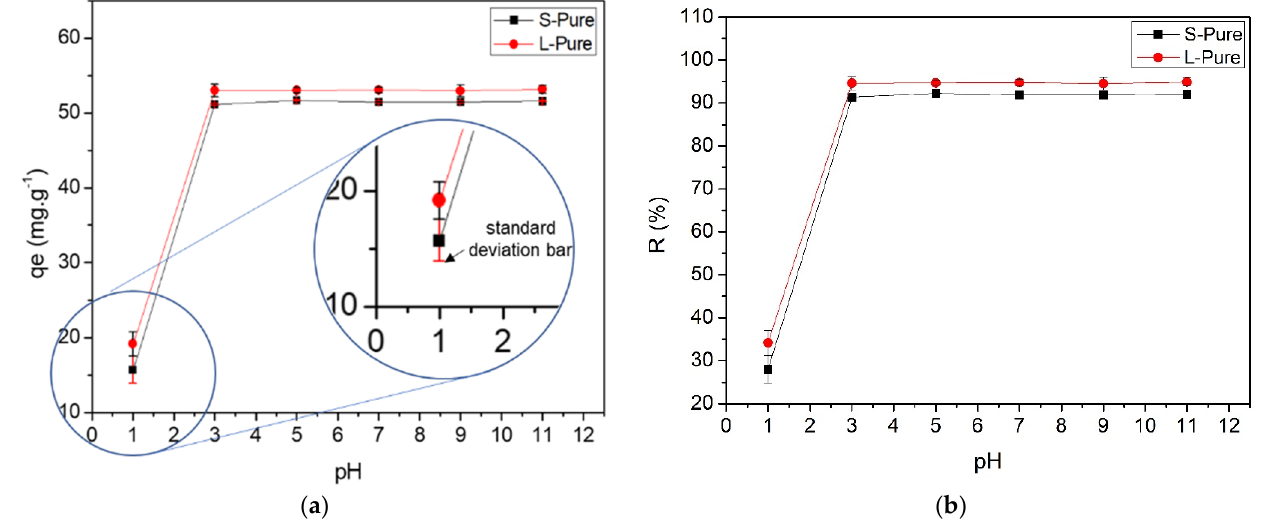
Figure 3. ( a ) Relation between the amount of dye adsorbed as a function of pH and ( b ) adsorption efficiency.